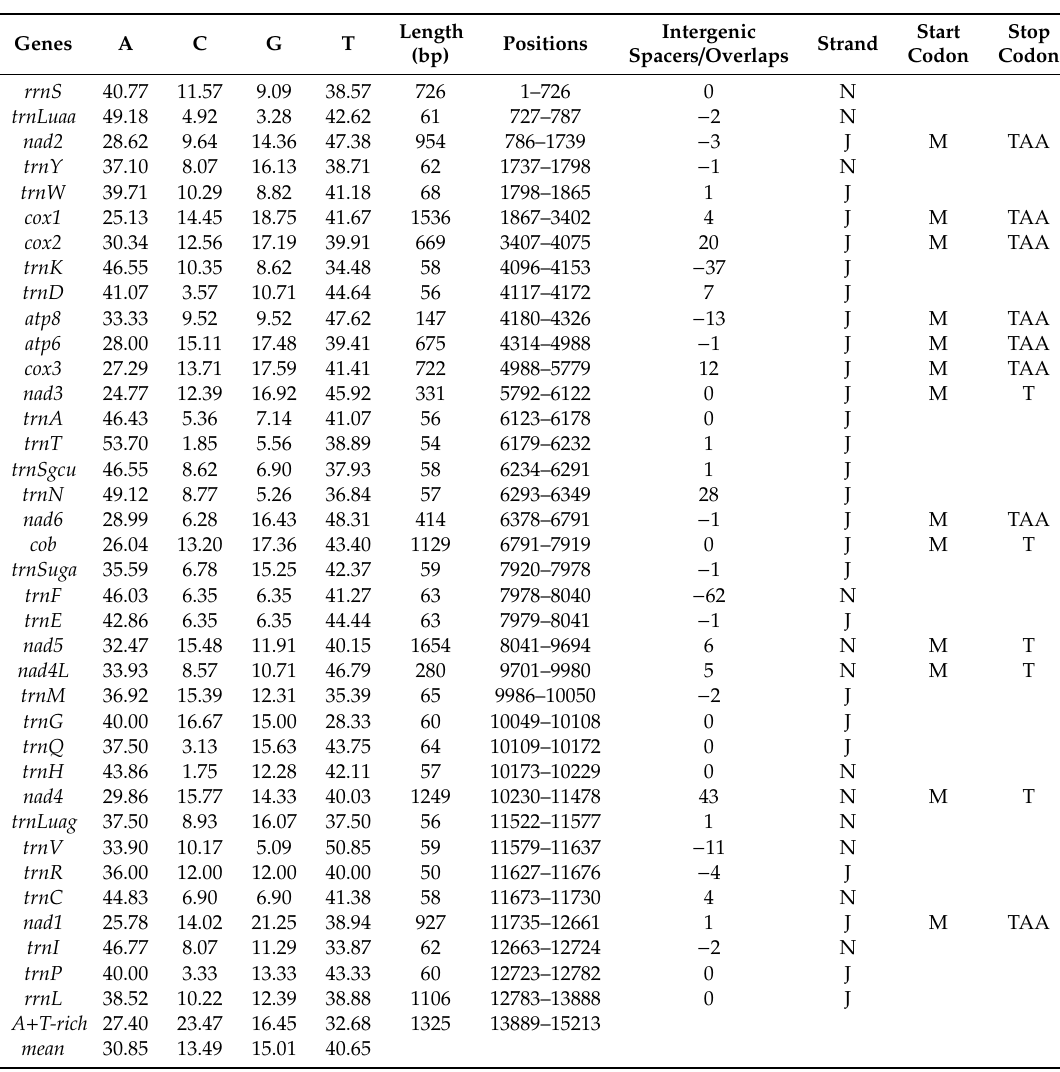
Table 2. Annotation of Acerentomon microrhinus mitochondrial genome. Nucleotide composition is calculated on the coding strand; position refers to GenBank NC_026666; spacers (positive numbers) and overlaps (negative) are calculated with respect to the following